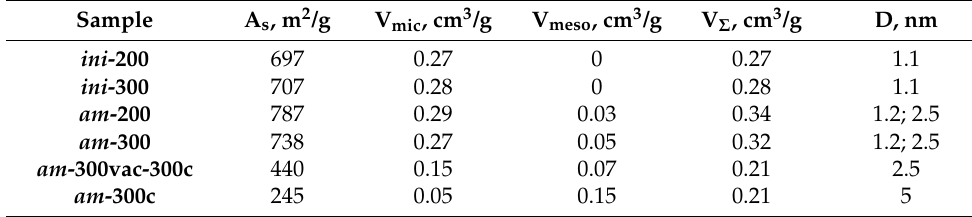
Figure 4. ( a ) N 2 ( − 196 ◦ C) adsorption isotherms for ini -300 , am -300 , am -300vac-300c and am -300c samples; ( b ) corresponding pore size distributions (NLDFT, adsorption branch). Table 2. Textural parameters for obtained samples.